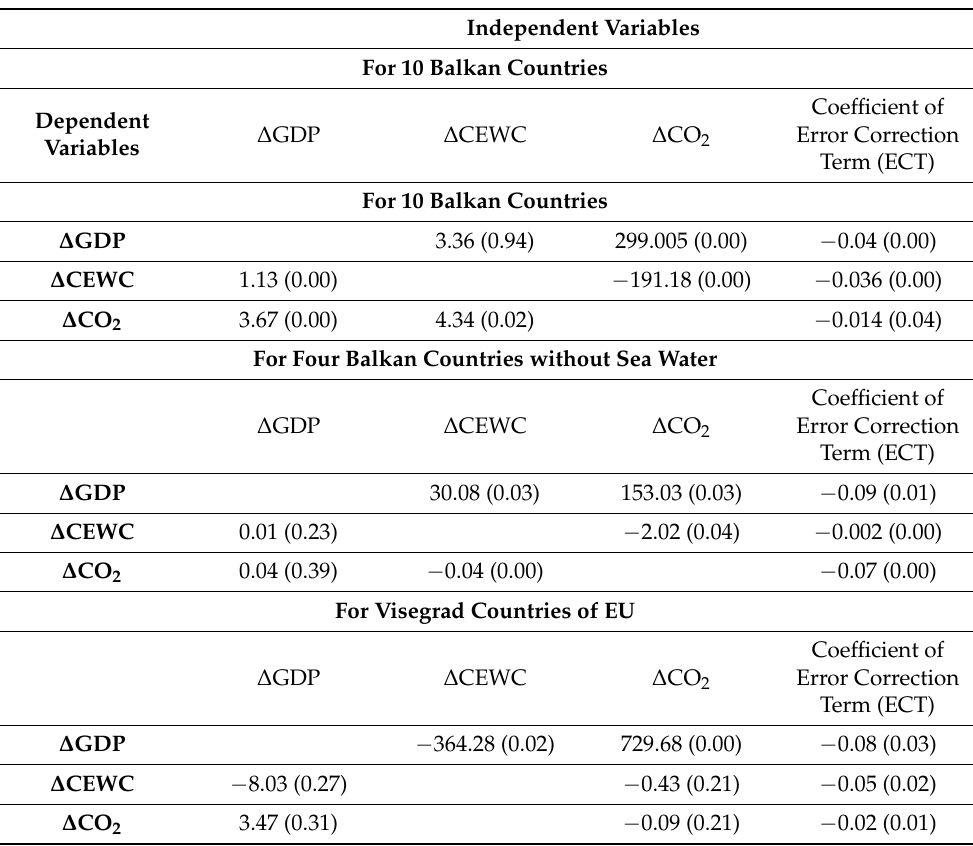
Table 7. Result of Vector Error Correction Mechanism